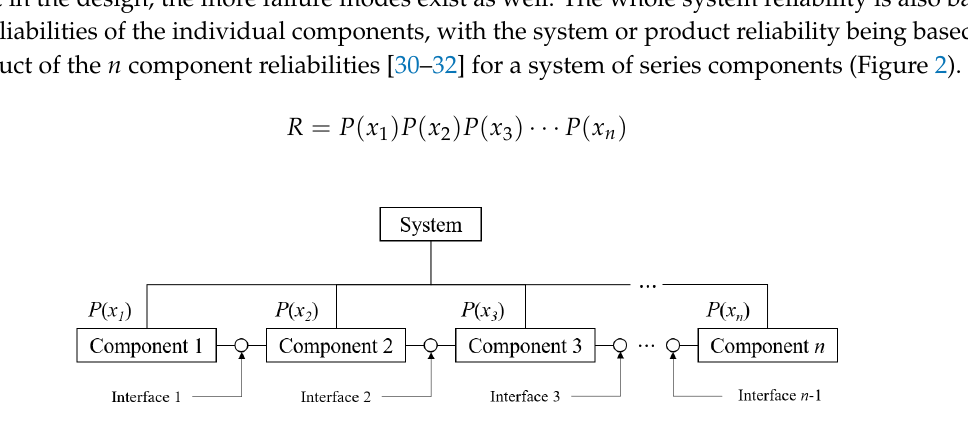
Figure 2. System reliabilities and interfaces